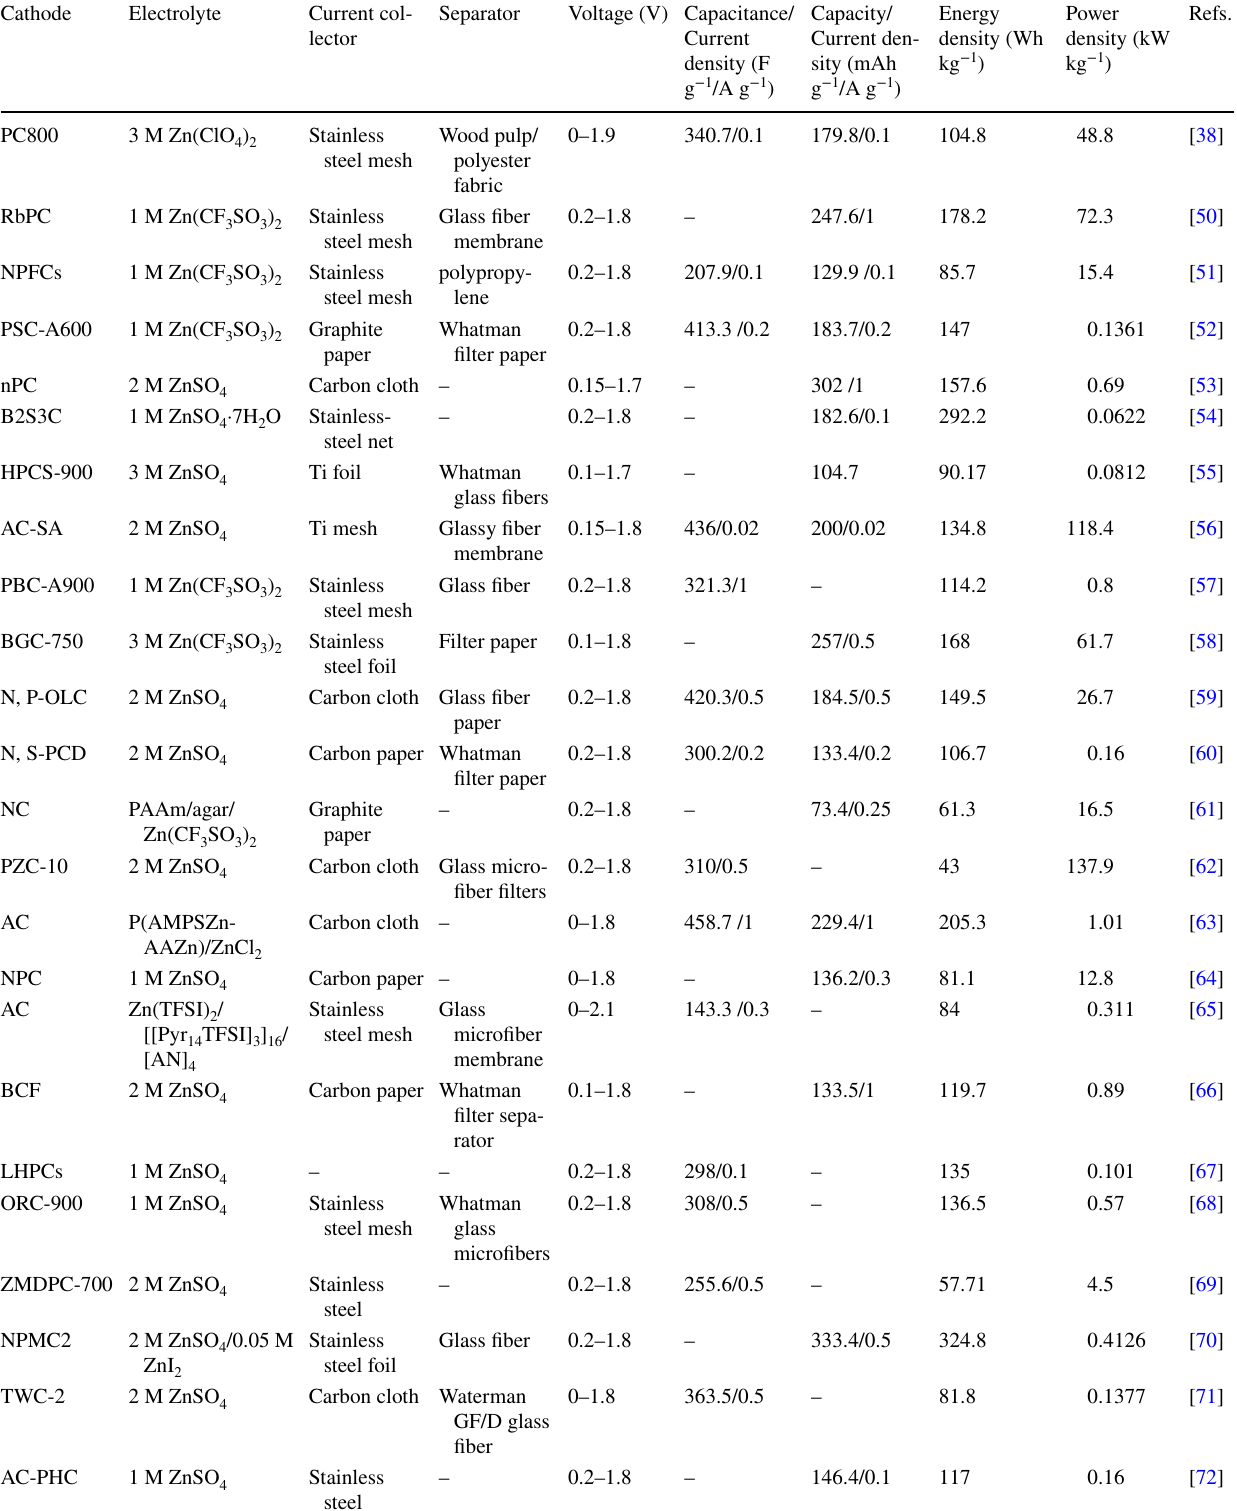
Table 1 A summary of current collectors and separators for ZIHCs Cathode